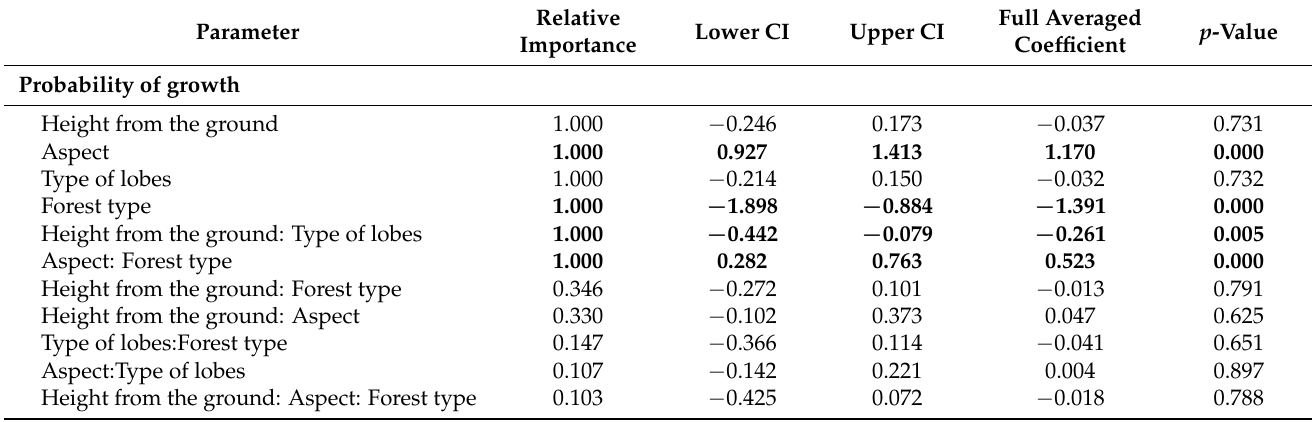
Table 1. Full averaging of generalized linear mixed model coefficients among models showing a delta AICc < 2. Significant interactions are in bold. Variables with sum >0.65 and with a significant Wald test are shown in